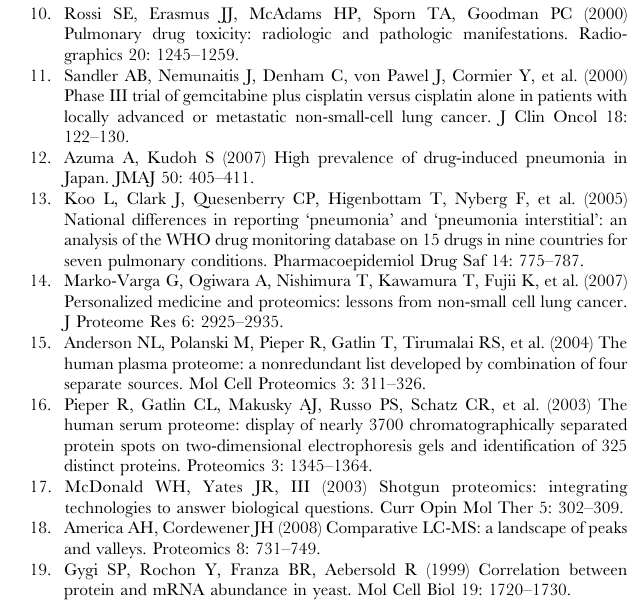
Table S1 Characteristics of study subjects (NSCLC patients treated with gefitinib) included in proteomics analyses. Table S2 Quality control results of sample preparation for 181 study samples, by LC-MS/MS measurement batches. Table S3 Protein Identification from the selected peaks. Table S4 Antibodies used for Western Blot